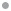
Comparison of the neutralizing capacity of the antivenoms manufactured by INS-COL (A-C), PROBIOL (D-F), ICP (G-I) towards the hemorrhagic effect caused by the venoms of B. asper (sensu stricto) (●), B. rhombeatus (●), B. ayerbei (○). Hemorrhagic lesions were measured as hemorrhagic units (HaU) [55] 2 h after intradermal injection of 10 MHD (challenge dose) mixed with antivenom in the ratios indicated in the figure. Each point represents the mean ± SD of four replicates. In all assays, statistically significant differences (p<0.05) were observed among the ratios 500–1000 μL antivenom/mg venom compared to the positive control.